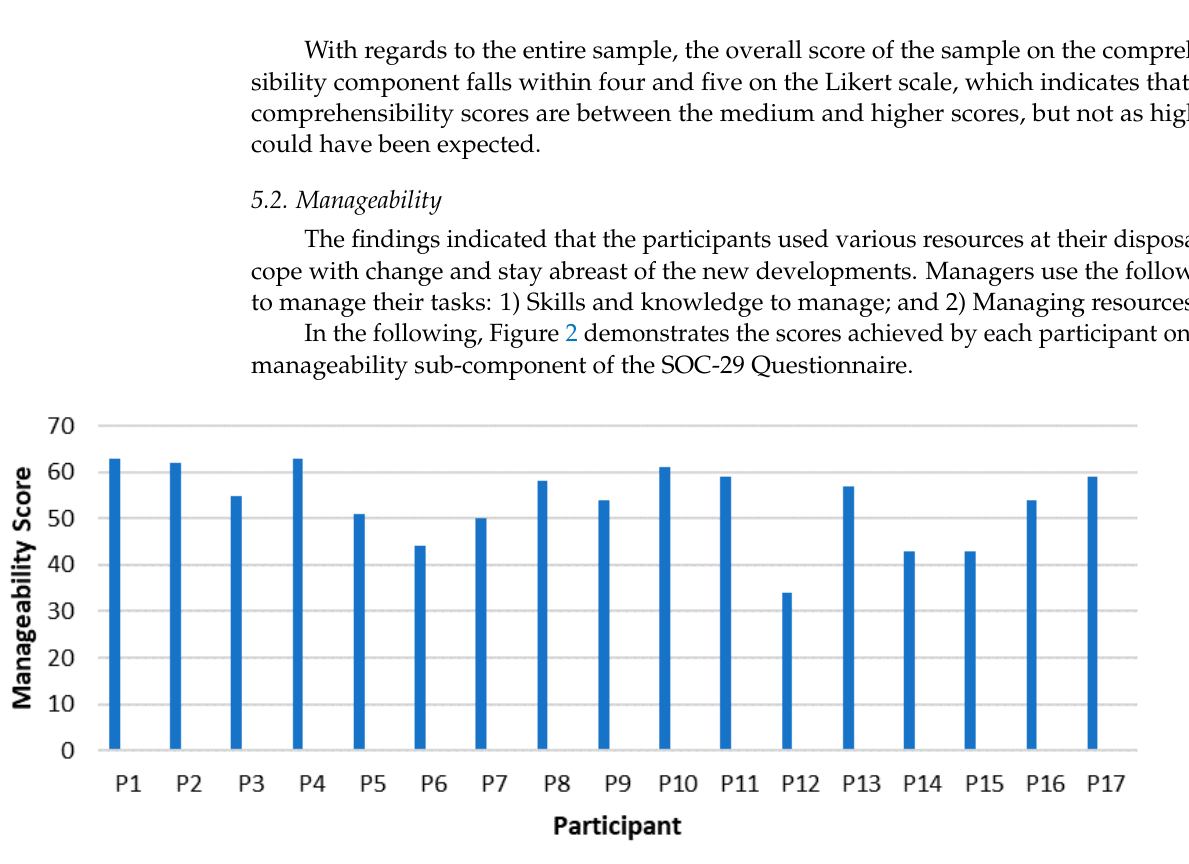
Figure 2. Manageability in managers.